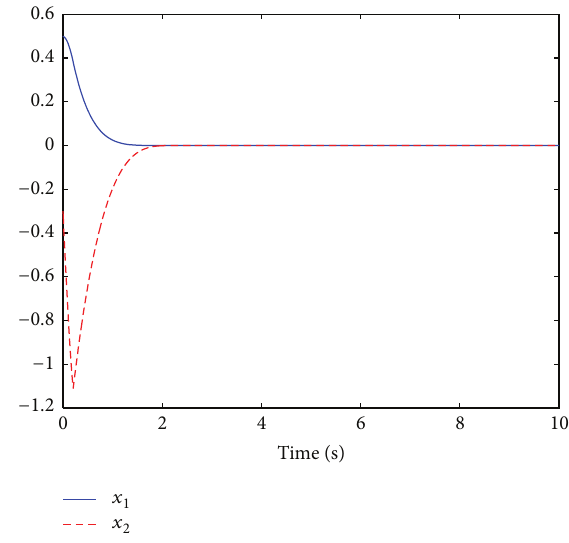
Figure 1: The trajectories of system states.